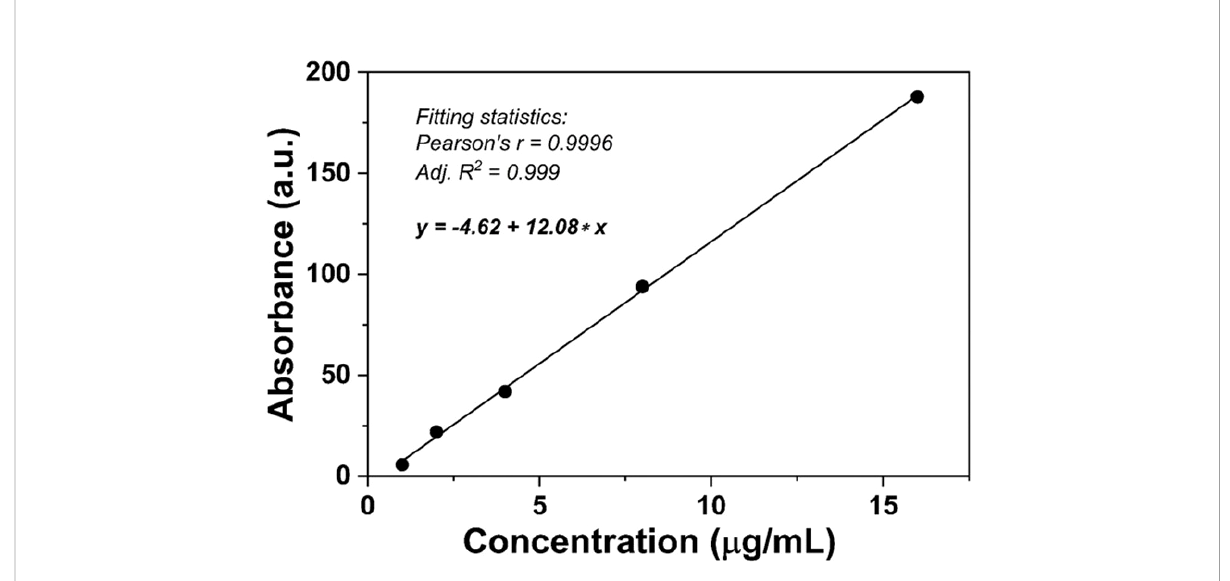
FIGURE 2 Standard curve of DOX absorbance as a function of